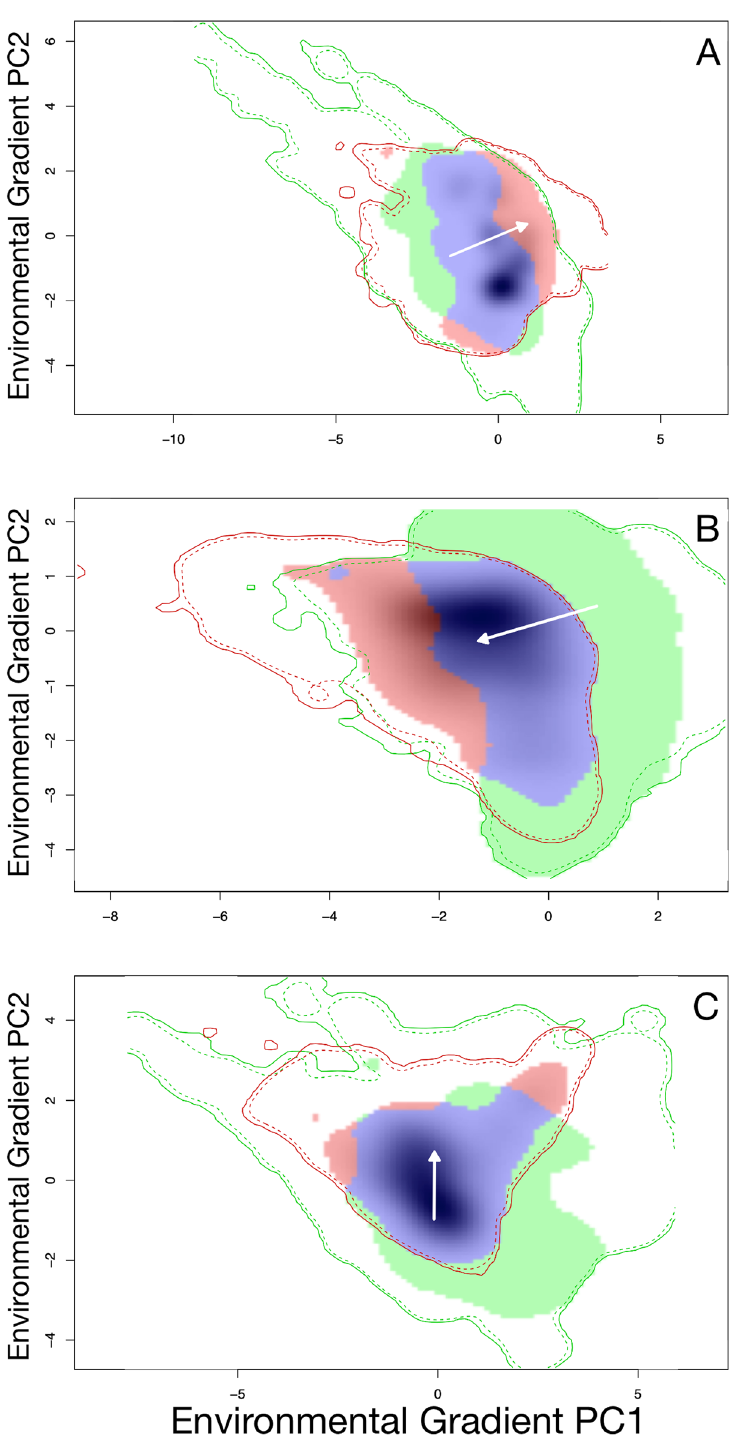
Figure 3. Estimates of niche overlap and shift in hoary bats from their native to their colonized ranges as hypothesized by their phylogenetic divergence. Plots ( A – C ) represent pairwise comparisons of niche overlap among species, where ( A ) = L. villosissimus vs. L. cinereus , ( B ) = L. cinereus vs. L. semotus , and ( C ) = L. villosissimus vs. L. semotus . White arrows indicate niche shifts from the centroid of the environmental range of the species set as reference (i.e. in ( A ) = L. villosissimus , in ( B ) = L. cinereus , and in ( C ) = L. villosissimus ) to the centroid of the other species range (arrowhead). Blue shading highlights areas of niche overlap between species environmental ranges. Reference species does not include density shading to aid visualization of differences. In all plots, solid contour illustrates the full range (100%) of background environmental space available and dashed contour represents 50% at each spatial scale. Environmental gradients of PC1 and PC2 represent 48% and 19%, 44% and 26%, and 48% and 25% of the variation in plot ( A ), ( B ), and ( C ),